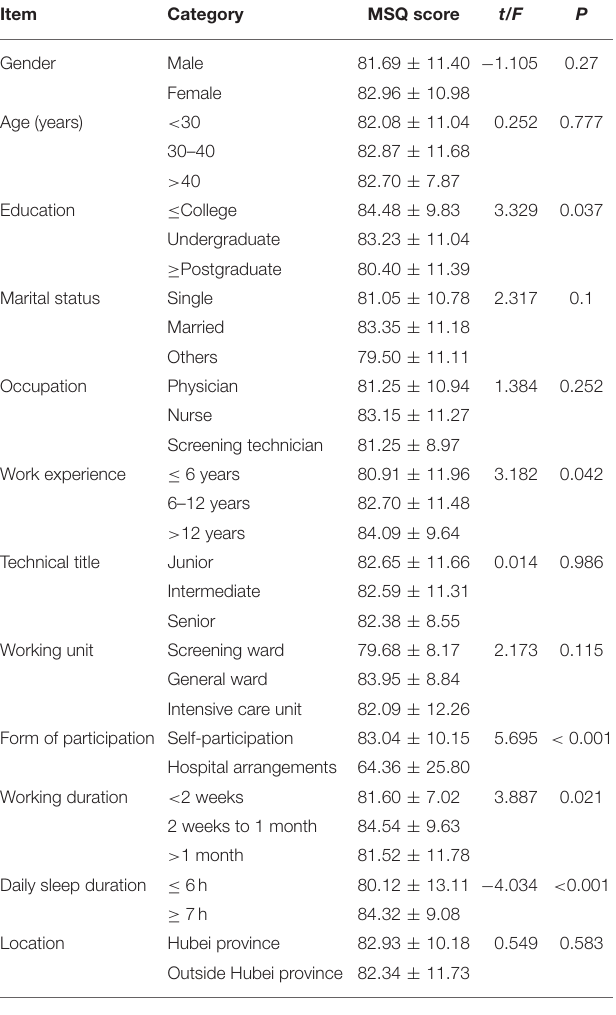
TABLE 3 | Comparison of job satisfaction scores among frontline medical staff with various demographic and job characteristics ( ¯x + s ).